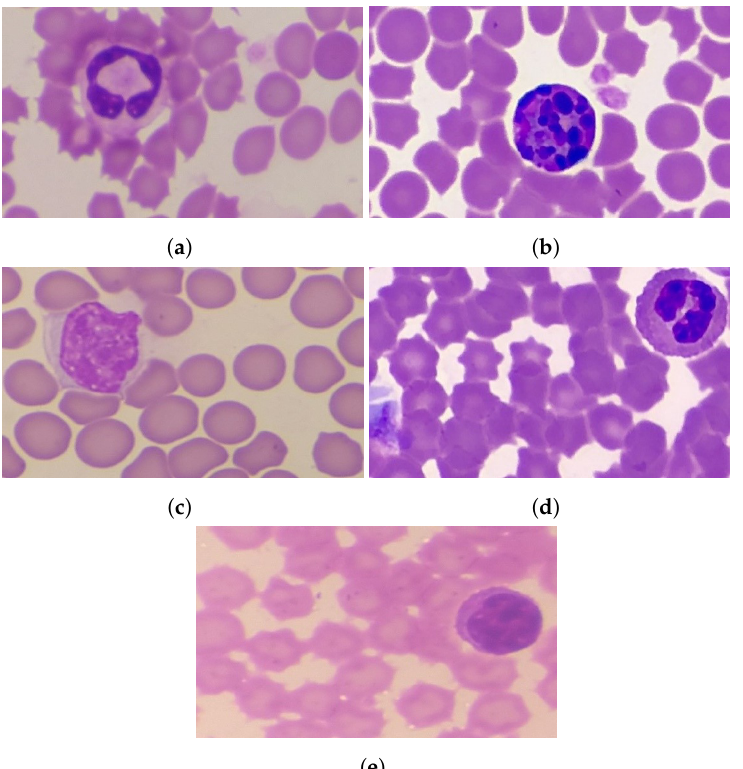
Figure 1. Types of WBC. ( a ) Neutrophils, ( b ) Basophils, ( c ) Eosinophils, ( d ) Monocytes, and ( e )